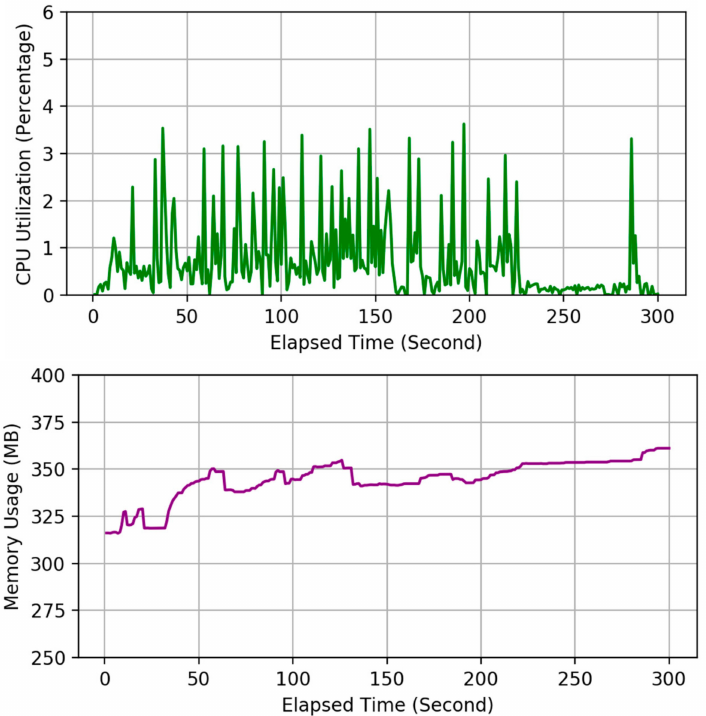
Figure 11. CPU utilization and memory usage of the CoVSCode client in a five-minute duration of a real-time collaboration